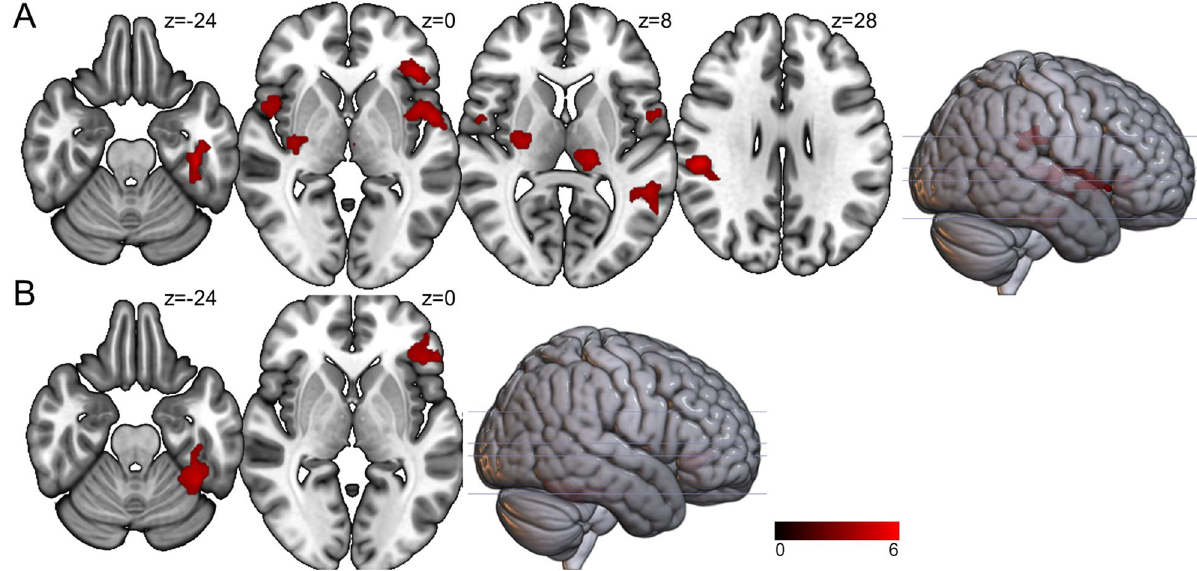
Figure 1. Brain regions whose functional connectivity with the left dorsal caudate was correlated with the plasma leptin level, with between-group differences. The left dorsal caudate-seeded functional connectivity was significantly correlated with the plasma leptin level among the patients with ( A ) bipolar I disorder and ( B ) bipolar II disorder. The coordinates of the peak voxel are presented in Table 2. Significance was thresholded at the uncorrected voxel level p = 0.001, followed by the FWE-corrected cluster level p = 0.05. The color bar denotes the t -scores. Figures are displayed according to neurological convention (left =